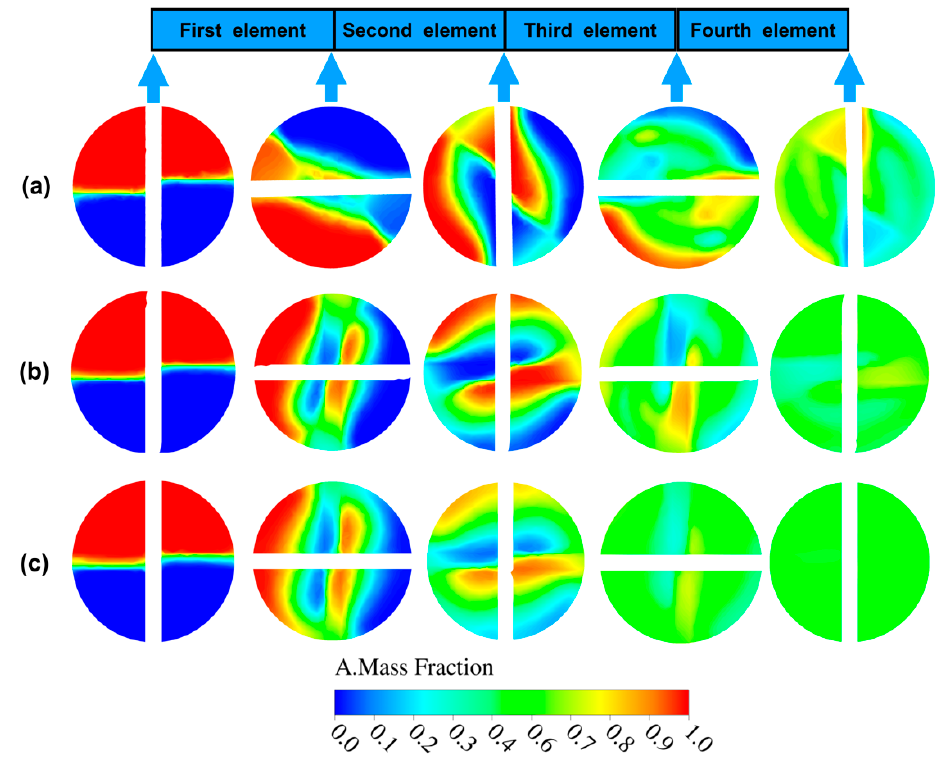
Figure 9. Effect of aspect ratio on cross sectional profiles of concentration at Re = 1: ( a ) AR = 0.4 ( b ) AR = 0.8 ( c ) AR = 1.5.